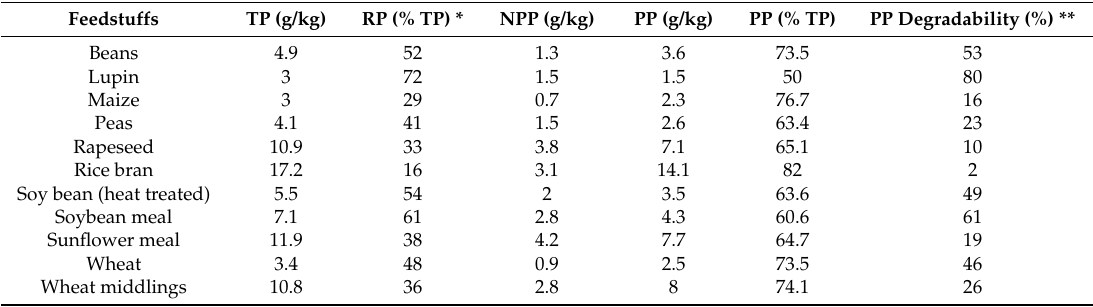
Table 3. Total P (TP) (g/kg), retainable P (RP) (% of TP), non-phytate P (NPP) (g/kg), phytate P (PP) (g/kg), PP (% of TP) and calculated PP degradability (%) of some of the feedstuffs in three-week-old broilers [2].